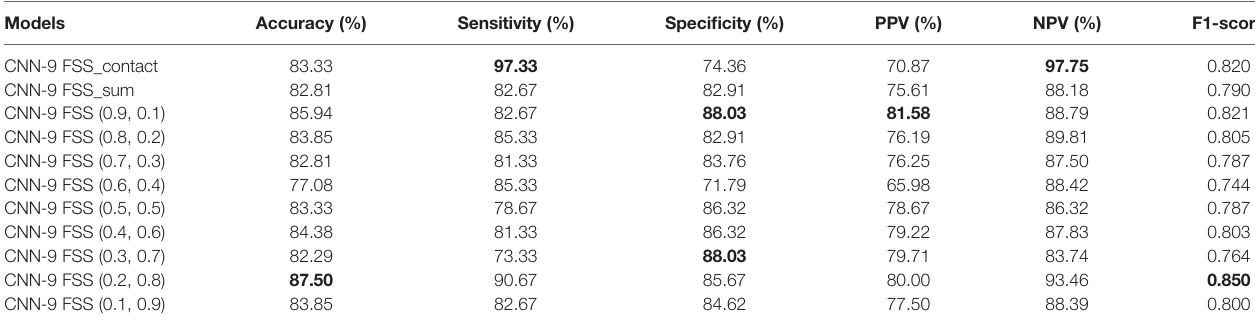
TABLE 6 | Performance of the model with different feature connection methods. Models